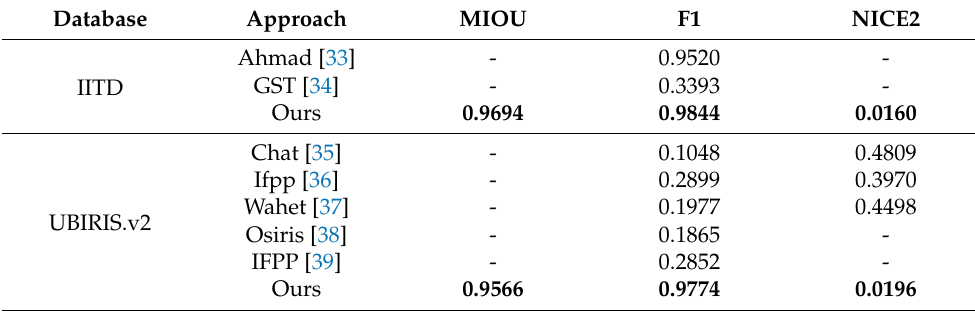
Table 5. Comparison with conventional algorithms on two iris databases.